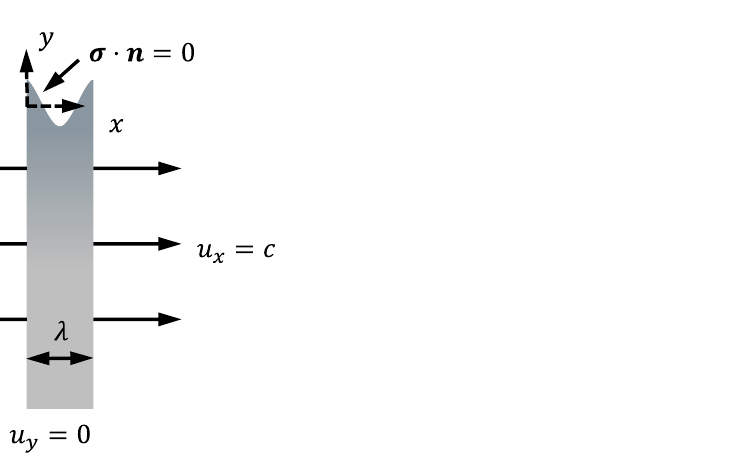
Figure 6. Mechanical calculation model for FEM. Traction-free is taken at the surface, and the uniform displacement is applied at the vertical boundries. For the bottom boundry, the vertical displacement is fixed at zero.